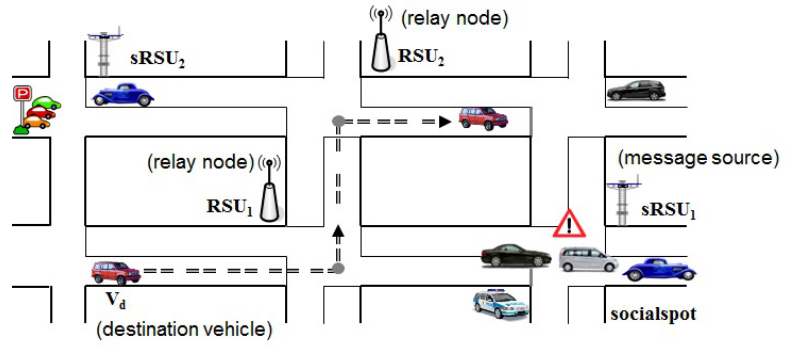
Figure 1. Service scenario of trajectory-based message